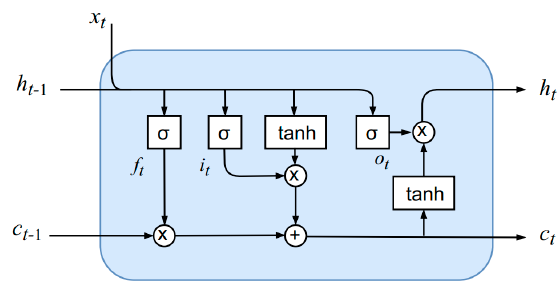
Figure 6. Structure of the LSTM.